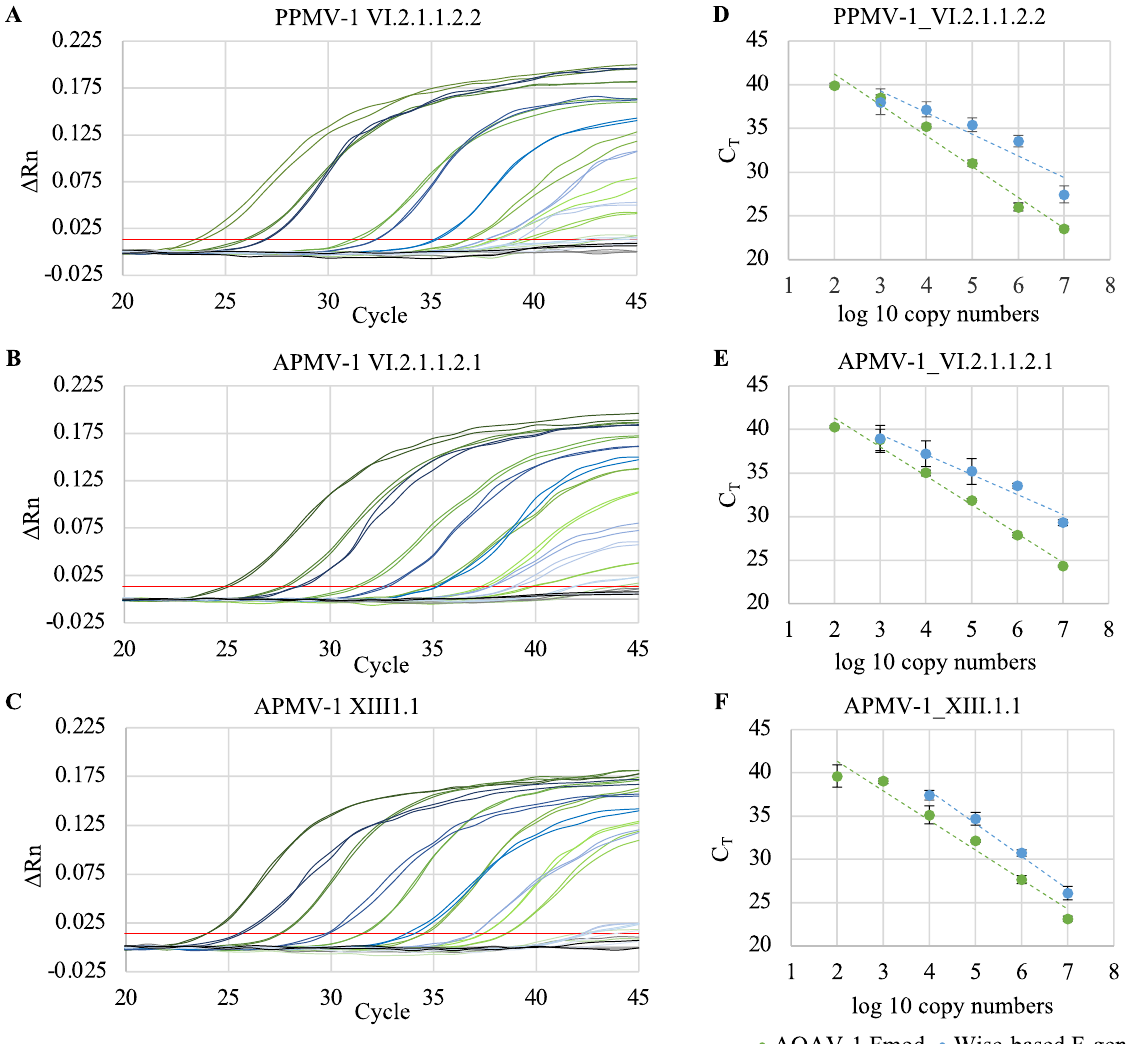
Figure 2. Comparison of the new modified rRT-PCR assay (AOAV-1 Fmod) with the original Wise- based rRT-PCR assay. Serial tenfold dilutions of quantitated in vitro-transcribed RNAs (10 2 to 10 7 RNA copies) of different AOAV-1 reference strains were used as templates. ( A – C ) Amplification plots. Red line: threshold (0.014), gray/black line: negative control, green lines: AOAV-1 Fmod assay, blue lines: Wise-based assay. For each reference RNA one representative experiment (in duplicates) out of three independent experiments is shown. ( D – F ) Regression analysis. Results are presented as mean CT values of three independent experiments, each performed in